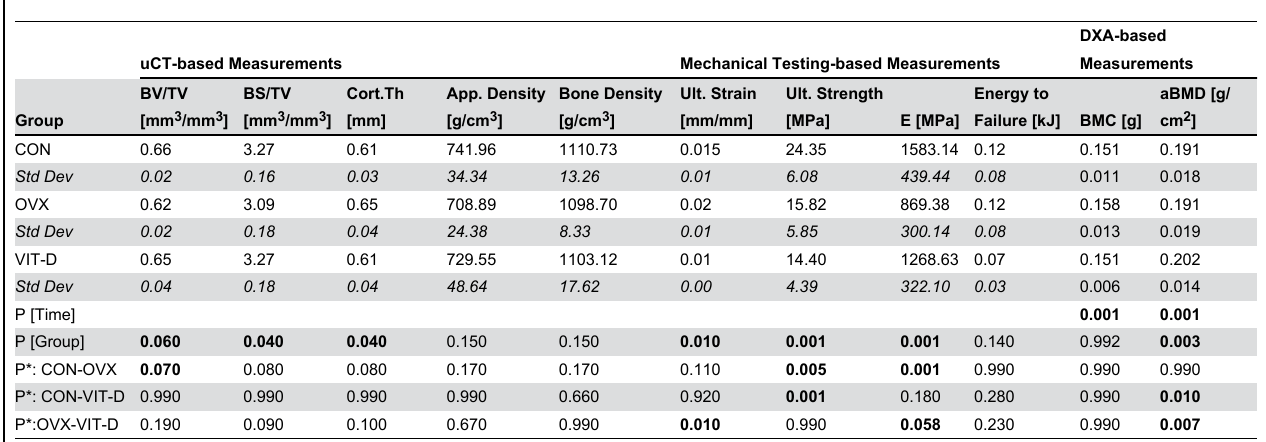
Table 2. μCT based morphometric indices, mechanical results and DXA based densitometric values for cortical bone specimens.